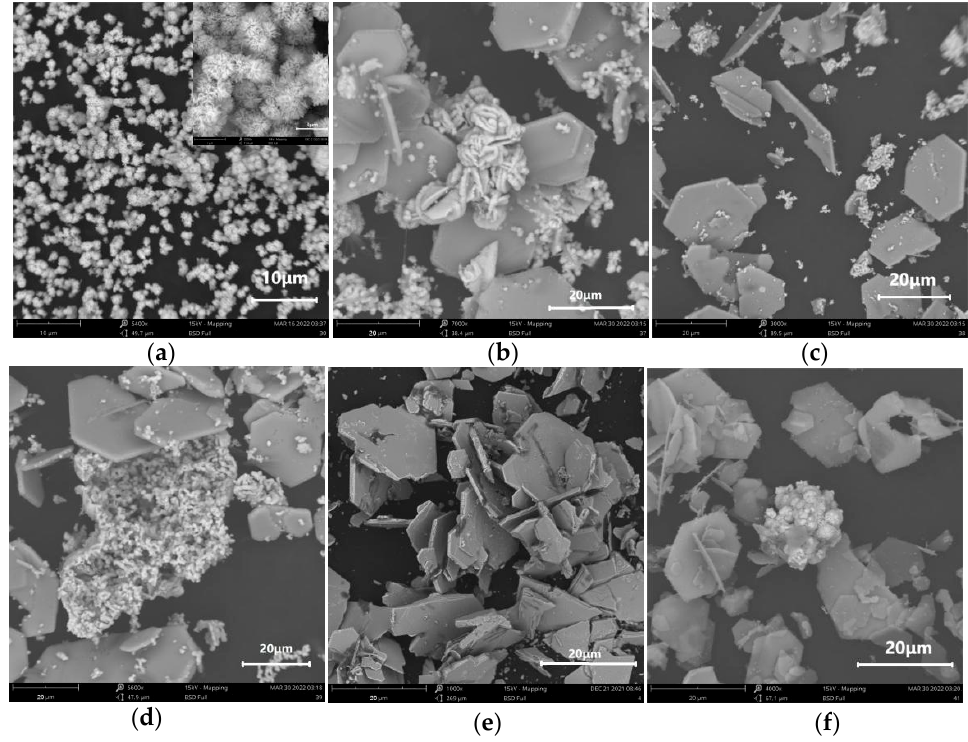
Figure 4. SnO 2 morphology with 50 mg PVP, reacting for 12 h, and V = 1:1: ( a ) 200, ( b ) 190, ( c ) 180, ( d ) 170, ( e ) 160, and ( f ) 150 °C.